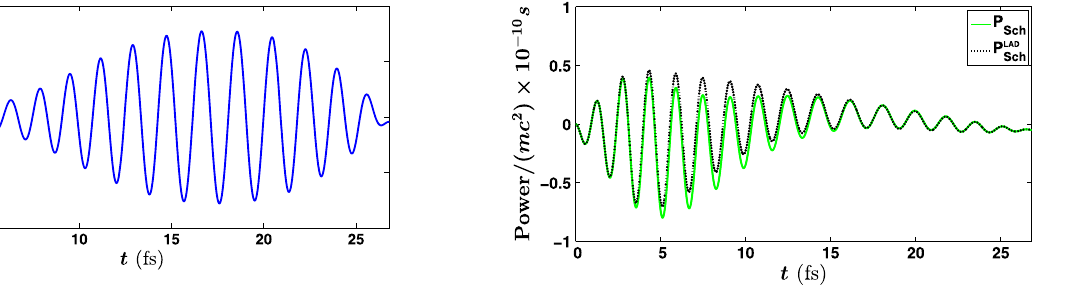
ð t Þ and P LAD ð t Þ for the sinusoidal-envelope FIG. 16. P Sch Sch circularly polarized plane wave with parameters given in Fig.